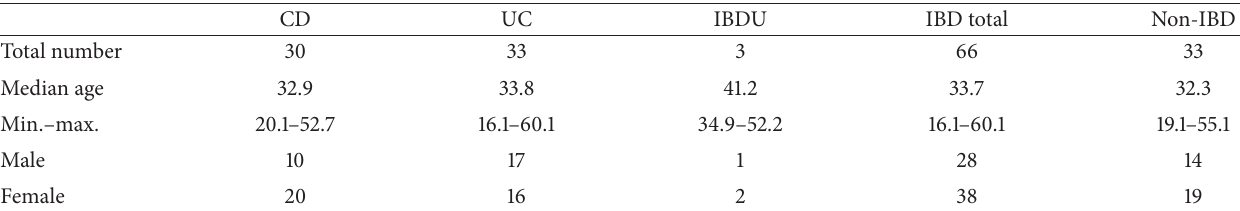
Table 1: Patient